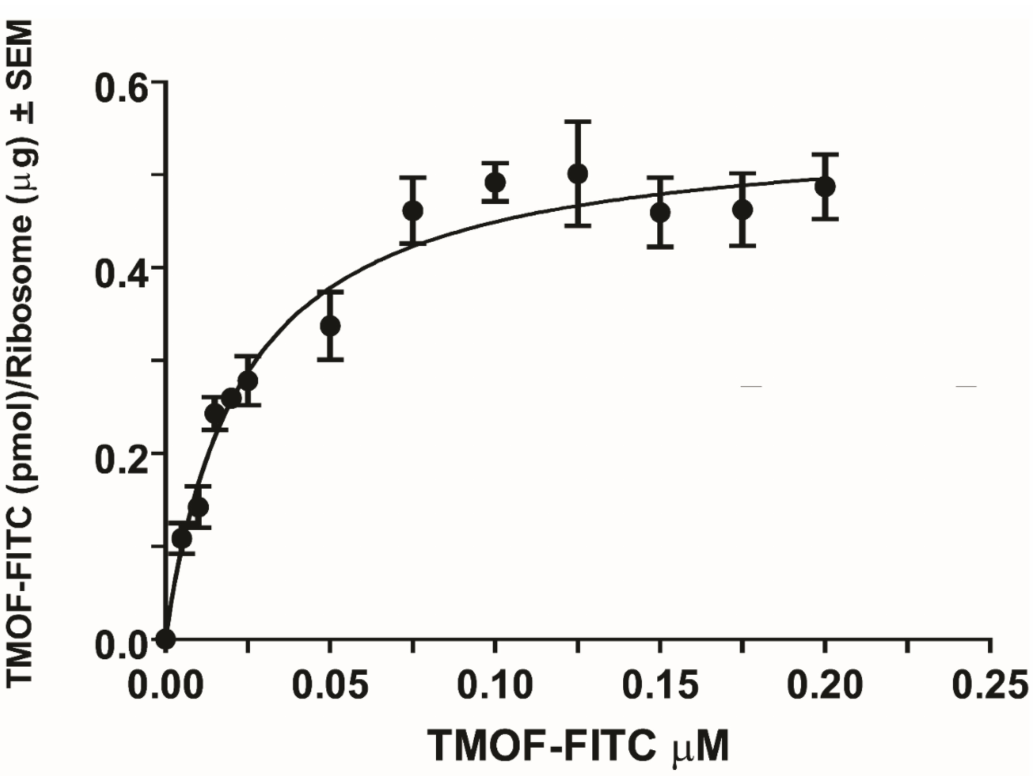
Figure 4. Specific binding of Aea TMOF to E.coli- purified ribosomes expressed as Aea TMOF-FITC (pmo/Ribosome ( µ g)) showing Michaelis Menten binding kinetics and using nonlinear regression (R 2 = 0.84). Binding results were corrected for nonspecific binding by incubating ribosomes without Aea TMOF-FITC or with Aea TMOF-FITC and without ribosomes (see Section 2.7). Each point is an average of six determinations ± SEM. The data represent results of one experiment from two inde- pendent experiments with similar results. K D = 23 ± 3.4 nM ± SEM, B max = 0.553 ± 0.023 pmol/ µ g ribosome ± SEM, and K assoc = 4.3 × 10 7 M − 1